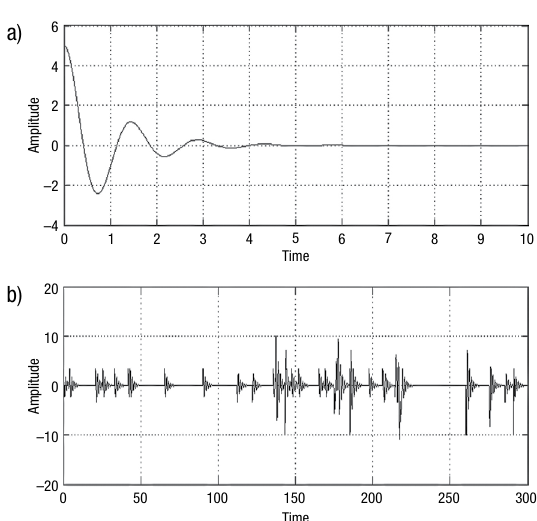
Fig. 11. Primary oscillation (simulated path 1), oscillations with random disturbances (simulated path